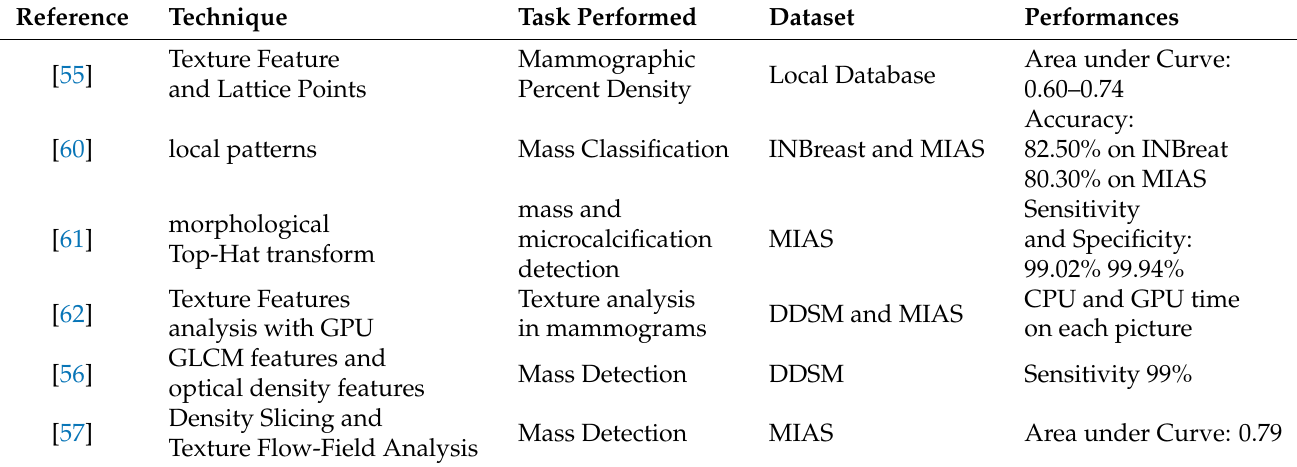
Table 3. Methods based on low-level image features